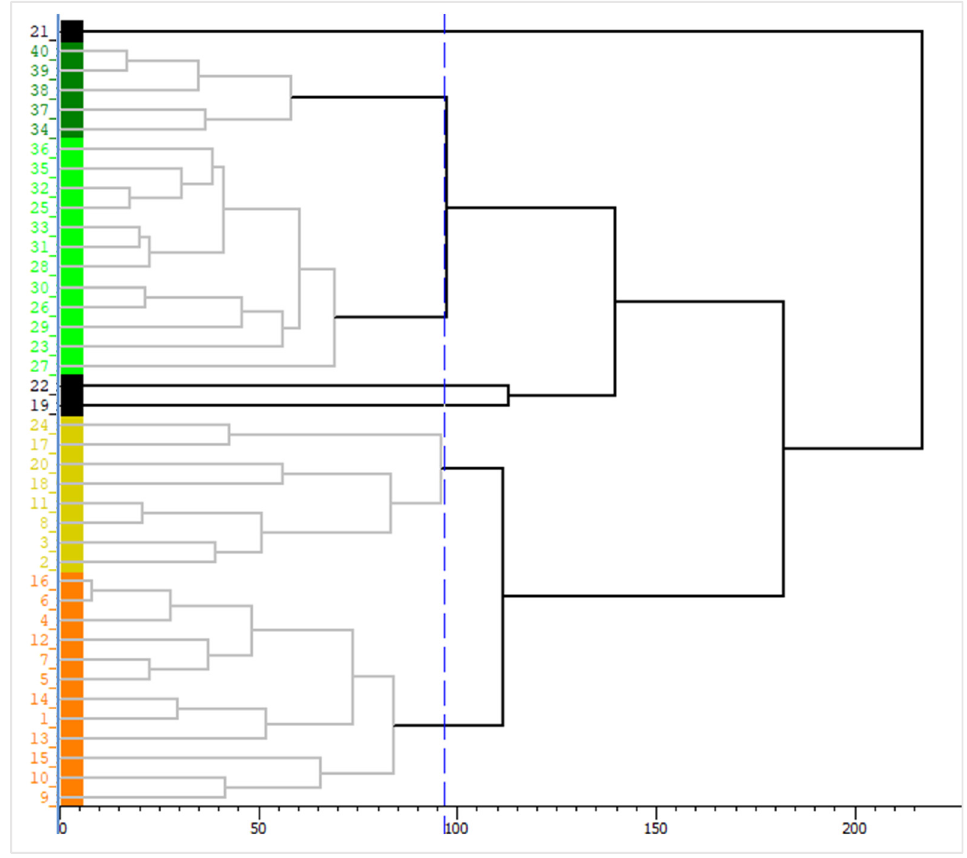
Figure 4. Dendrogram after cluster analysis based on the correlation matrix from 40 nickel laterite samples (cluster 1 = orange, cluster 2 = yellow, cluster 3 = light green, cluster 4 = dark green), X-axis shows the dissimilarity of the tie bars.